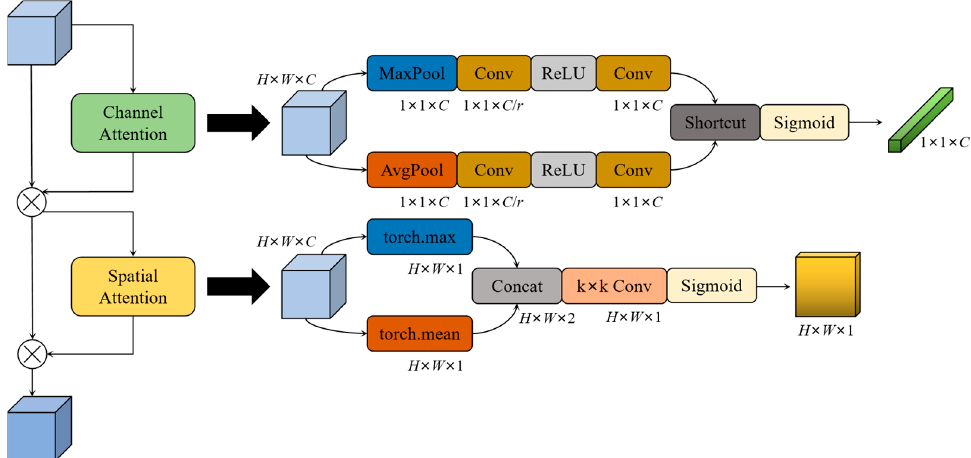
Figure 7. Diagram of CBAM. r denotes multiple dimension reduction in the channel a tt ention mod-